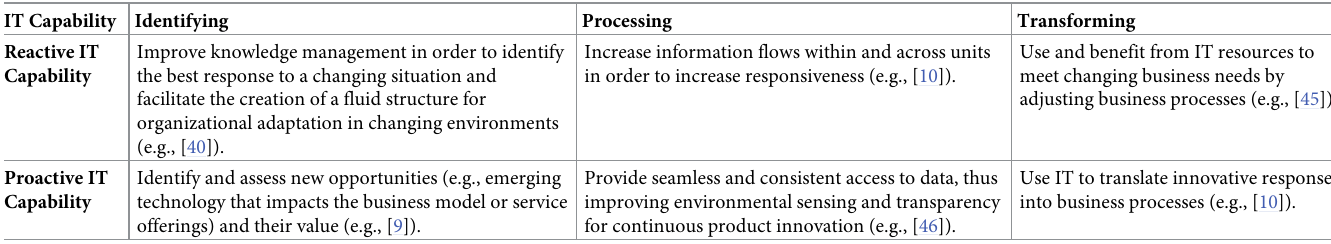
Table 1. Explanations for the relationship between IT capability and organizational agility.